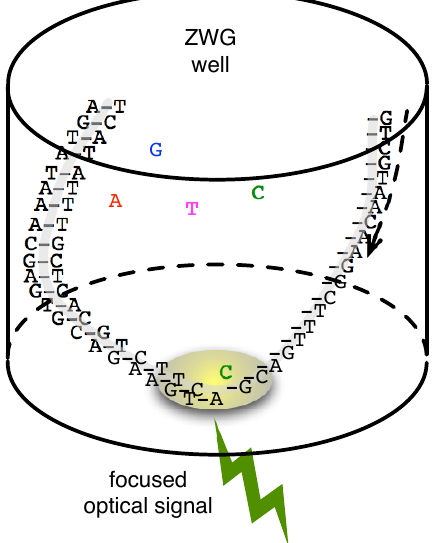
Figure 3. Strand sequencing confined to a signal focusing zero-mode wave waveguide as described in